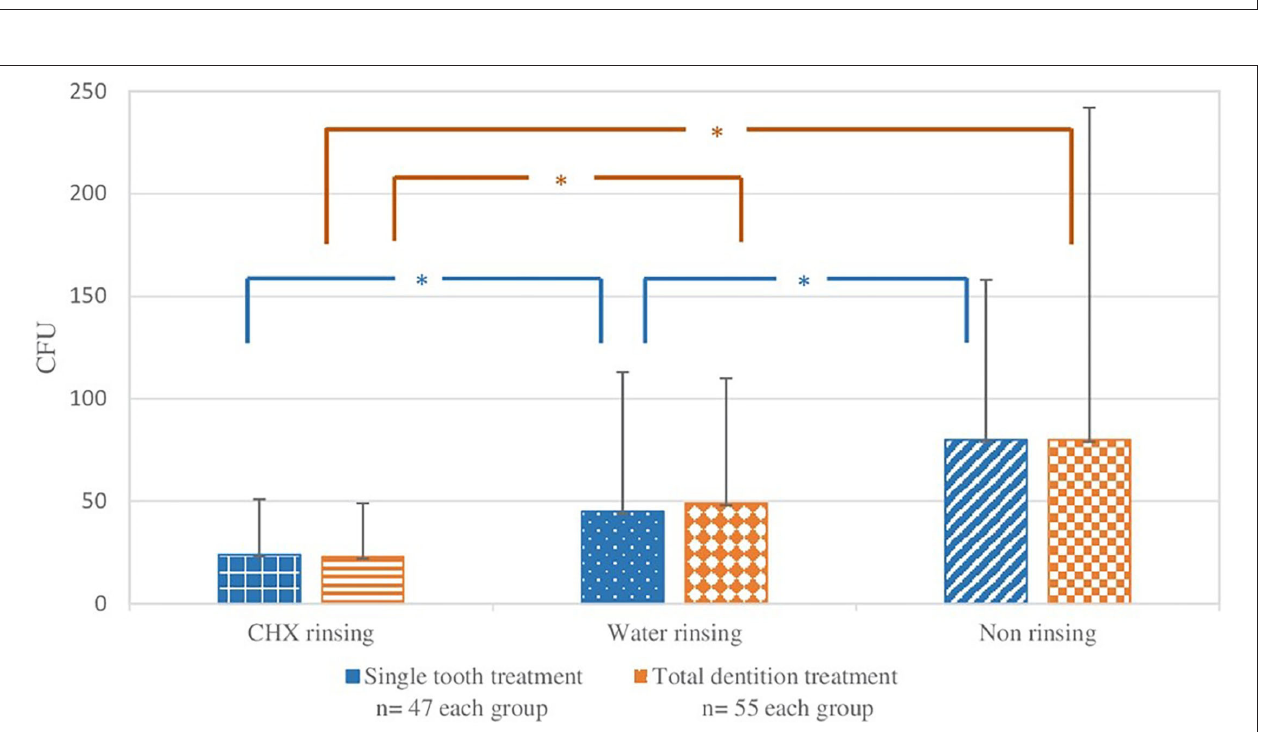
FIGURE 4 | Single-tooth and total dentition treatments. Bacterial load (colony-forming units, CFU) on the surgical mask behind the face shield in the three groups. The bars correspond to the mean value, the line on top to the ± standard deviation. Statistical significance ( p < 0.05) is marked with an asterisk.